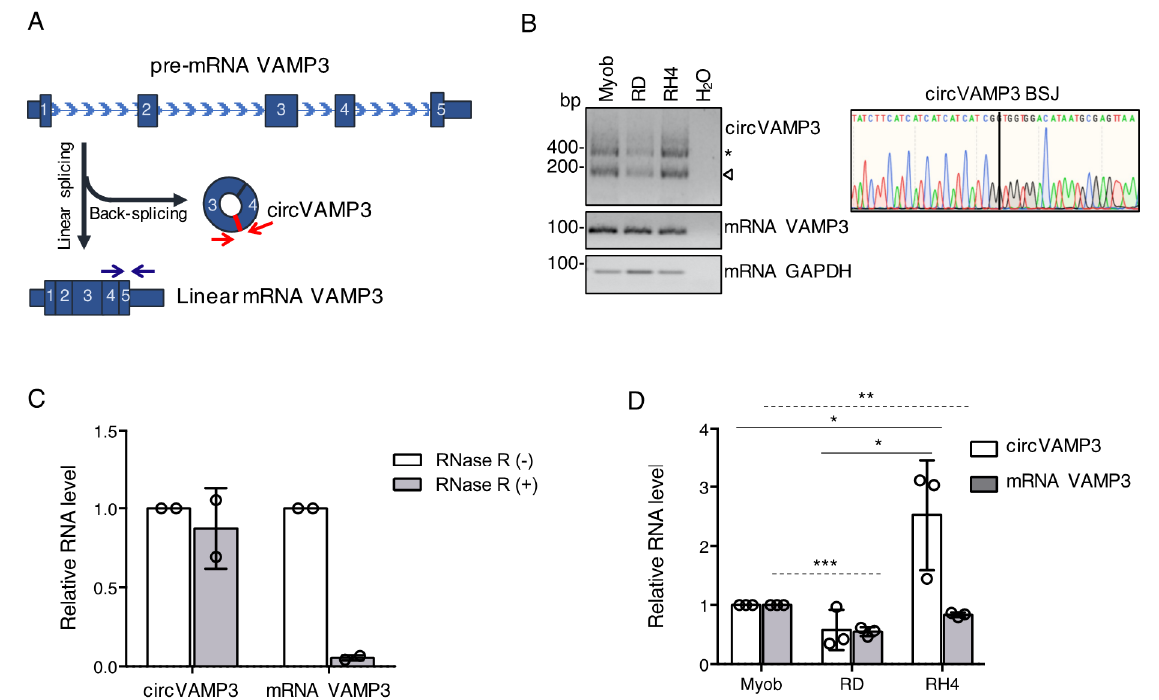
Figure 1. ( A ) Cartoon depicting the differential splicing of VAMP3 precursor transcript (pre-mRNA VAMP3) when it undergoes linear splicing to generate VAMP3 mRNA or back-splicing to produce circVAMP3. Convergent oligonucleotides to detect the linear mRNA and divergent oligonucleotides to detect the circRNA are depicted as arrows. Back-splicing junction (BSJ) is highlighted in red on circVAMP3 cartoon. ( B ) Left panel: RNA species detected by RT-PCR using oligonucleotides to detect circVAMP3, VAMP3 mRNA and GAPDH mRNA in myoblasts (Myob), RD, RH4 cells, and H 2 O negative control. CircVAMP3 oligonucleotides can amplify the circular RNA isoform (the band indicated by an arrow) and concatemers produced by consecutive reverse-transcription (the band indicated by an asterisk). Amplicon sizes (bp) are indicated on the left. Right panel: detail from the Sanger sequencing of circVAMP3 RT-PCR amplification, depicting the BSJ. ( C ) Relative RNA levels detected by qRT-PCR of circVAMP3 and VAMP3 mRNA after RNase R treatment. Data are represented as mean of fold changes ± standard deviation of two biological replicates, with dots representing individual datapoints. ( D ) Relative RNA levels of circVAMP3 and VAMP3 mRNA in myoblasts (Myob), RD and RH4 cells, detected by qRT-PCR. Data are represented as mean of fold changes ± standard deviation of three biological replicates, with dots representing individual datapoints. Continue horizontal bars refer to statistical confrontations for circVAMP3; dashed horizontal bars refer to statistical confrontations for linear VAMP3. Where statistical analysis was performed, the ratio of each sample versus its experimental control was tested by a two-tailed unpaired Student’s t -test. *: p -value < 0.05, **: p -value < 0.01, ***: p -value < 0.001, ****: p -value < 0.0001.